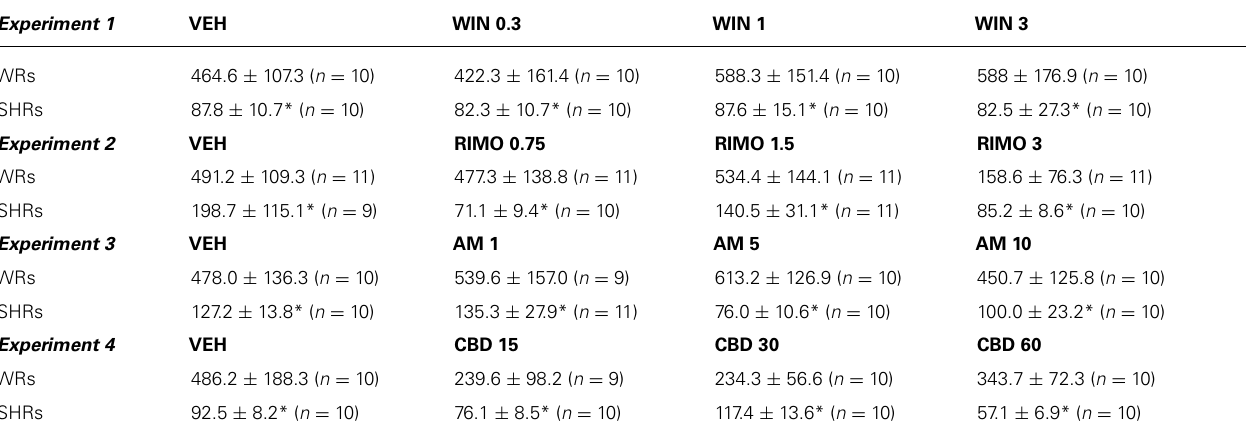
Table 1 |Acoustic startle response (ASR) ofWistar rats (WRs) and spontaneously hypertensive rats (SHRs) treated with vehicle (VEH), 0.3, 1, or 3 mg/kgWIN55212,2 (WIN – Experiment 1);VEH, 0.75, 1.5, or 3 mg/kg rimonabant (RIMO – Experiment 2);VEH, 1, 5, or 10 mg/kgAM404 (AM – Experiment 3);VEH, 15, 30, or 60 mg/kg cannabidiol (CBD – Experiment 4).